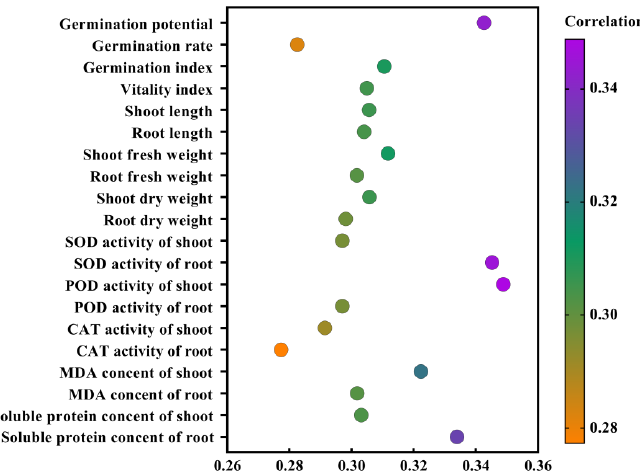
Figure 9. Analysis of the gray relational grade between high temperature stress and rice seed germination and the physiological index under melatonin concentration treatment.